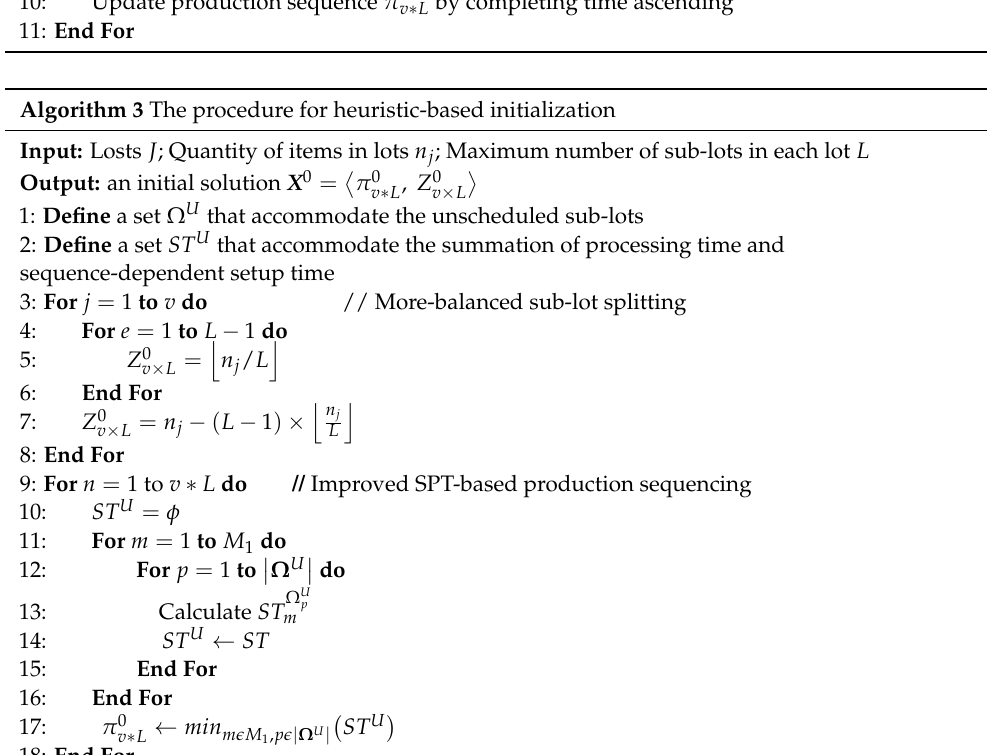
Algorithm 3 The procedure for heuristic-based